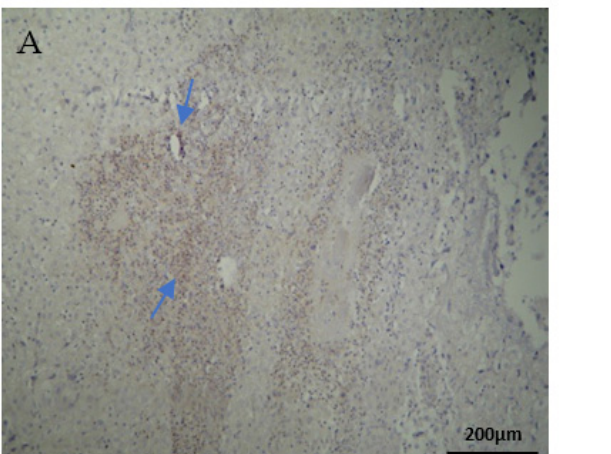
Figure 4. Evaluation of positive CD4 antigen expression. Control Group (CG): ( A ) No expression Figure 4 . Evaluation of positive CD4 antigen expression. Control Group (CG): ( Α ) No expression of of CD4 in the DP (4 × 4 magnification). ( B ) Moderate CD4 antigen expression in the DB (4 × 40 CD4 in the DP (4 × 4 magnification). ( Β ) Moderate CD4 antigen expression in the DB (4 × 40 magni- magnification). fication).